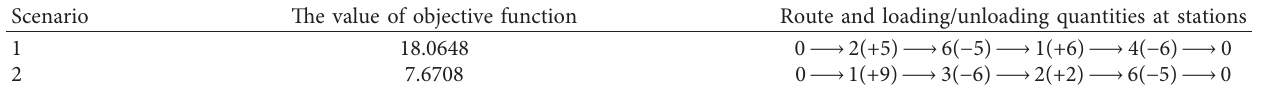
Table 11: The value of objective function and the route of the truck in different